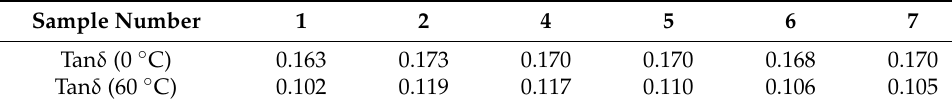
Table 3. tanδ of the CNT/WPRP/NR composites at 0 °C and 60 °C. Table 3. Tan δ of the CNT/WPRP/NR composites at 0 ◦ C and 60 ◦ C.